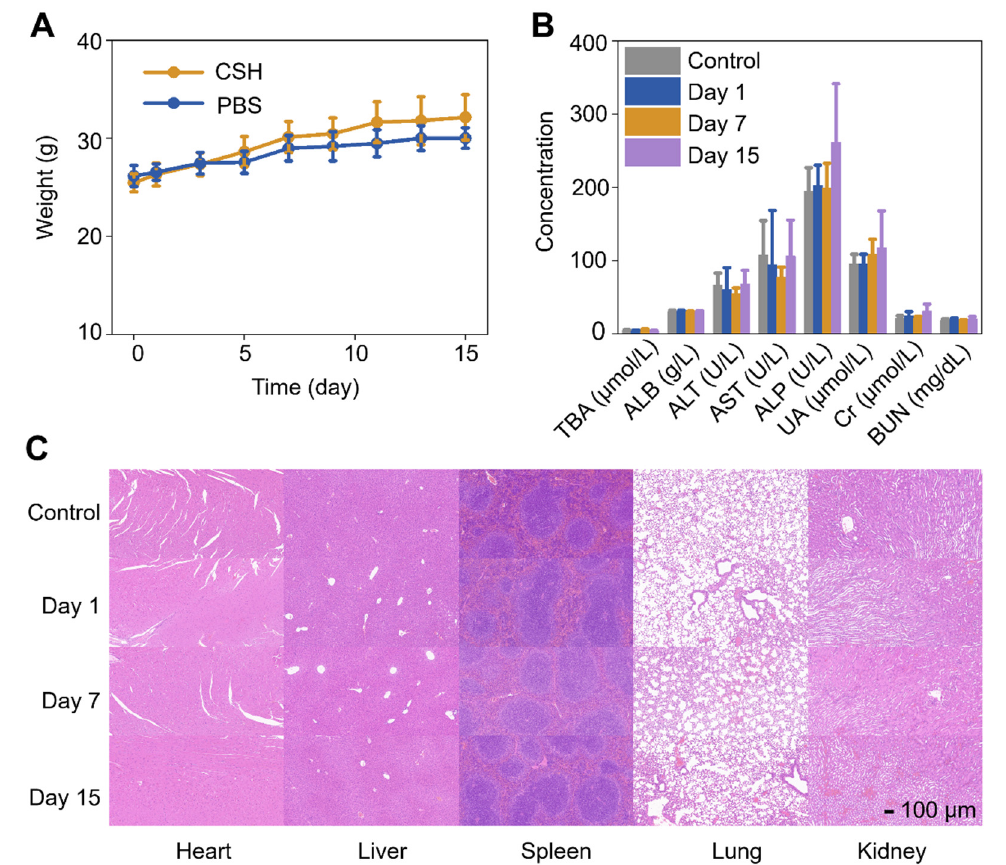
Figure 7. ( A ) Weight-changing curves of mice after being subcutaneously injected with PBS and 20 mg CuS/mL of CSH ( n = 5 in each group). ( B ) Blood biochemical indexes of mice measured after being treated with PBS for 15 days and CSH (20 mg CuS/mL) for 1, 7, and 15 days ( n = 5 in each group). ( C ) H&E-stained images of major organs of Kunming mice acquired after being treated with PBS for 15 days and CSH (20 mg CuS/mL) for 1, 7, and 15 days.